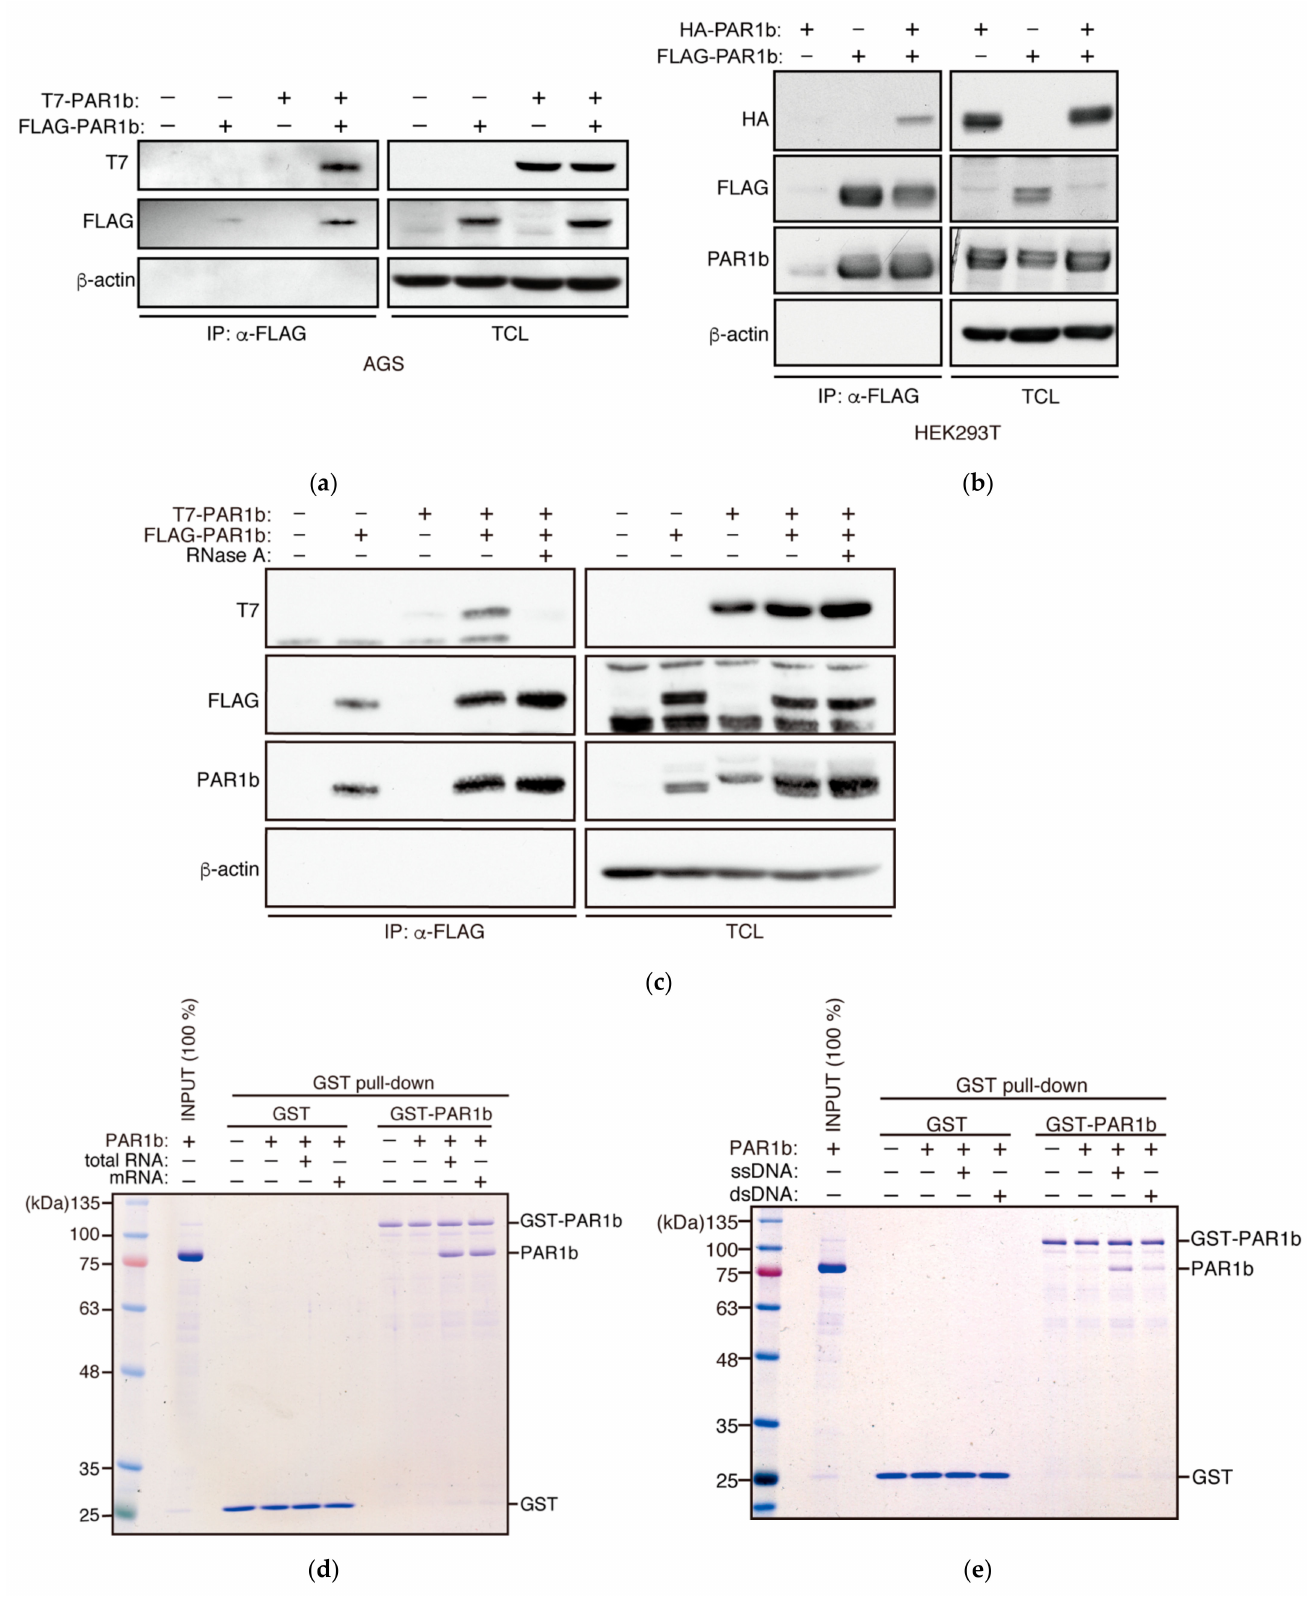
Figure 1. Nucleic acids mediate multimerization of PAR1b. ( a ) Multimerization of PAR1b in AGS cells. AGS cells were transiently transfected with expression vectors for FLAG-tagged PAR1b and T7-tagged PAR1b. After 24 h, total cell lysates (TCL) were prepared and subjected to immunoprecipitation